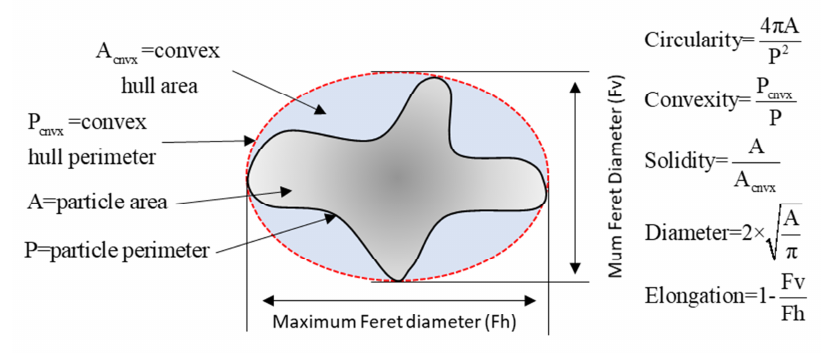
Figure 3. Shape factors that are used for model construction.